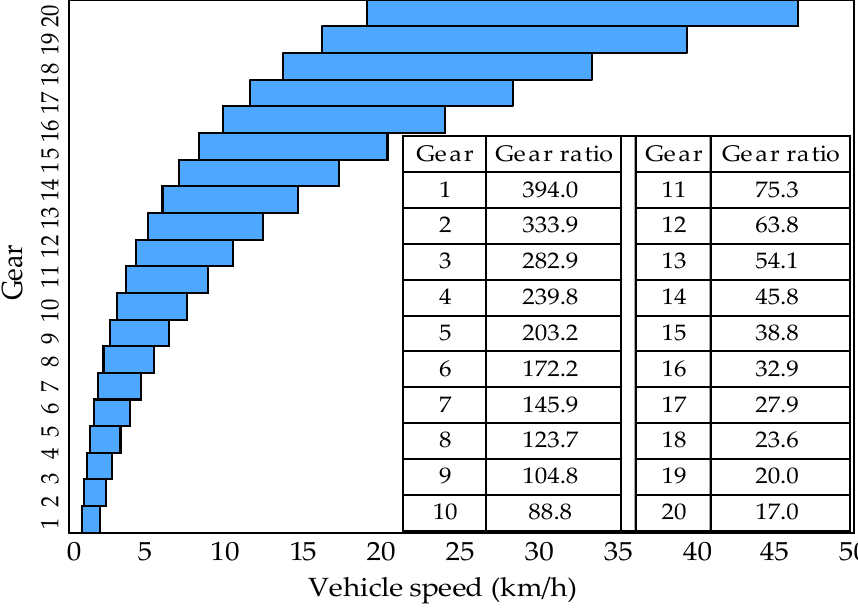
Figure 4. Travelling speed range versus speed ratios of overall drivetrain of different gears.